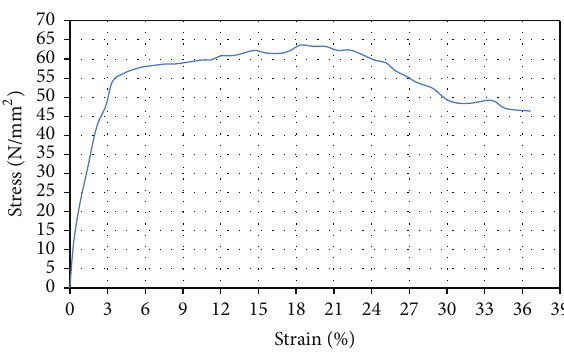
Figure 5: Stress-strain diagram.